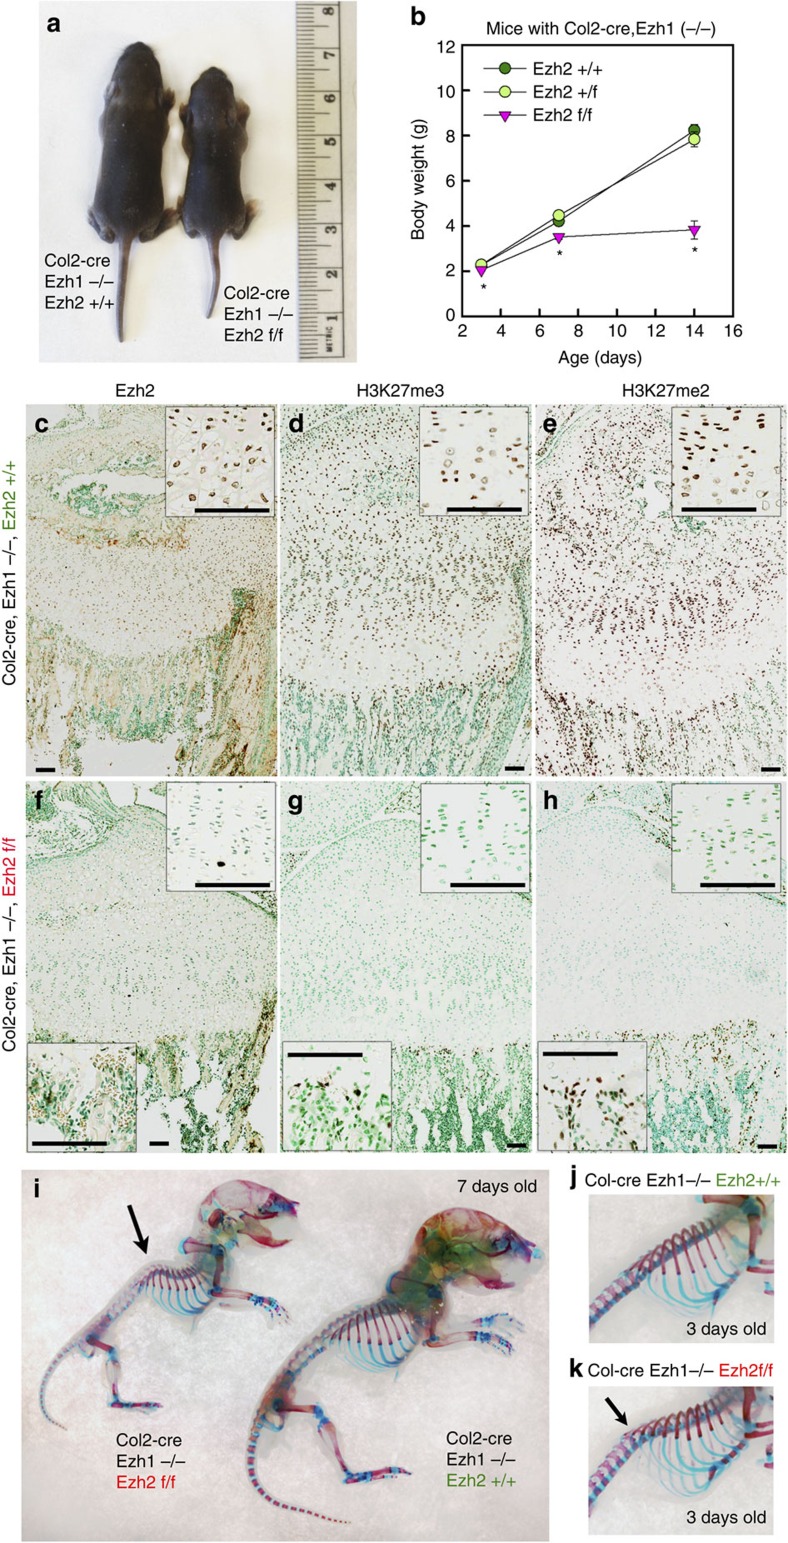
Ezh1/2 mice show growth retardation.(a) One-week-old littermates of Ezh2 wild-type (Col2-cre, Ezh1−/−, Ezh2+/+) and Ezh1/2 knockout (Col2-cre, Ezh1−/−, Ezh2f/f) mice. (b) Growth curve of Ezh2 wild-type, cartilage-specific heterozygotes and cartilage-specific knockout mice, all with Ezh1−/− background. *P<0.05 versus both wild type and heterozygotes within the same age group. (c–h) Proximal tibial growth plates of Ezh1−/− 1-week-old mice with cartilage-specific knockout for Ezh2 (d,f,h) or wild type for Ezh2 (c,e,g) immunostained (brown colour) for Ezh2 (c,d), H3K27me3 (e,f) and H3K27me2 (g,h). Higher-magnification images of growth plate chondrocytes and spongiosa osteoblasts (for Ezh2f/f) were included to better illustrate the presence or absence of signal. (i–k) Whole-mount staining of Ezh1−/− mice with cartilage-specific knockout for Ezh2 or wild type for Ezh2 7 days (i) and 3 days (j,k) of age, stained for bone (Alizarin red) and cartilage (Alcian blue). Arrow indicates abnormal spinal curvature. Error bars, ±s.e.m. Scale bars, 100 μm.